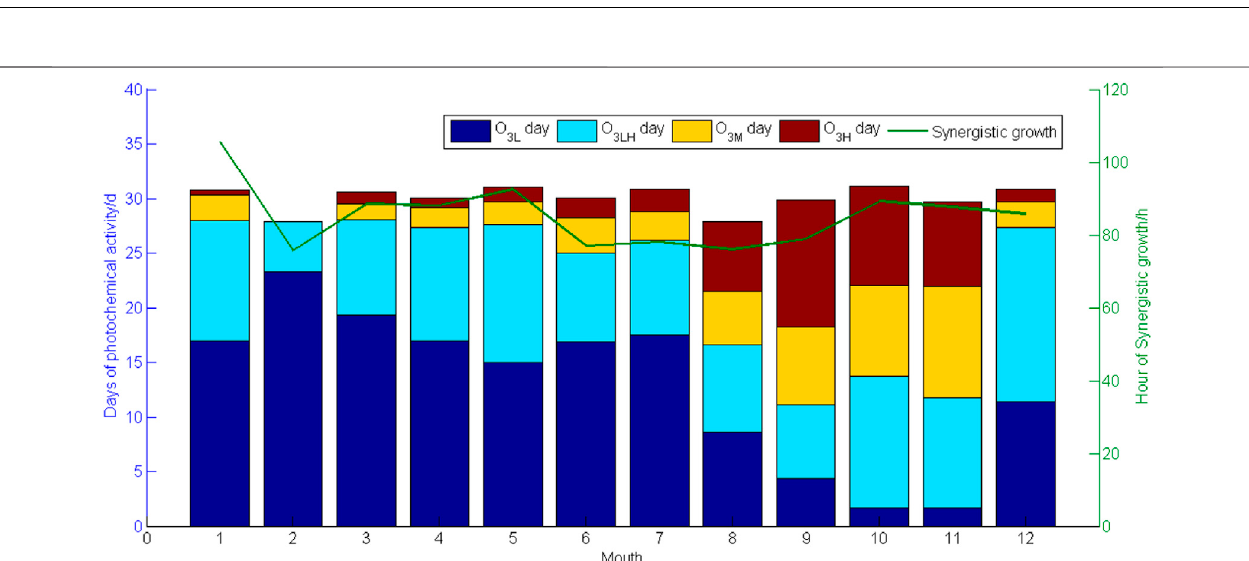
FIGURE 7 | Monthly averaged days of different photochemical reactivities and the average hours of coordinated increase.